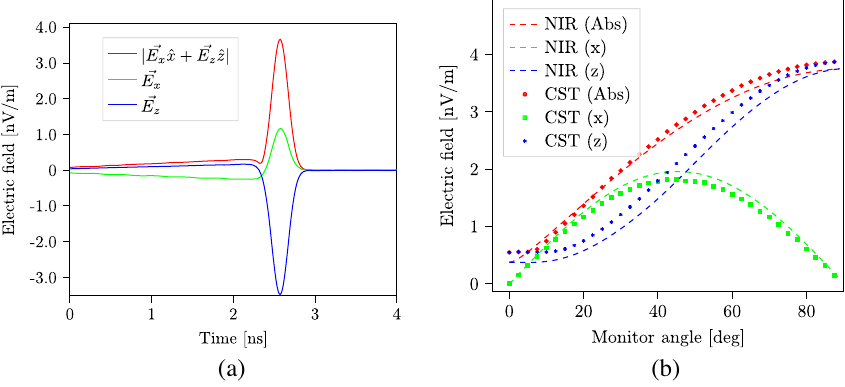
FIG. 9. (a) Time domain snapshot of all three components of the transition radiation electric field for beam velocity v ¼ β · c where β ¼ 0 . 15 . (b) Field amplitudes as a function of monitor angle obtained from CST in comparison with NIR.